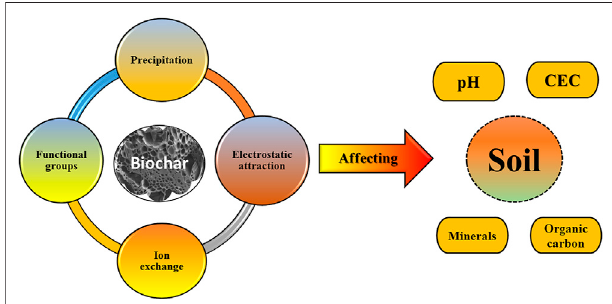
FIGURE10| Featuresofbiocharin fl uencing thesoilproperties(adapted and redrawn from Wang et al., 2020).